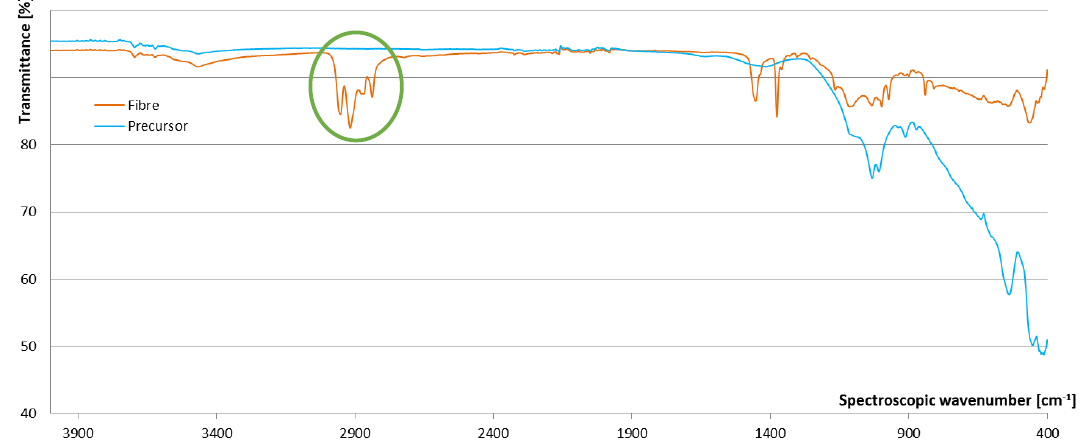
Figure 3. FTIR measurement of precursor sieved below 1 mm (blue line), and fibre (orange line).